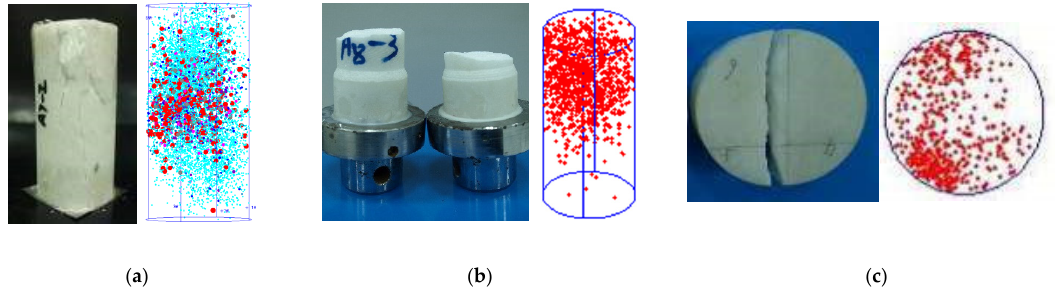
Figure 6. Comparison of the AE event spatial distributions and macroscopic failure patterns under different loading modes: ( a ) UCT, ( b ) DTT, ( c ) ITT.